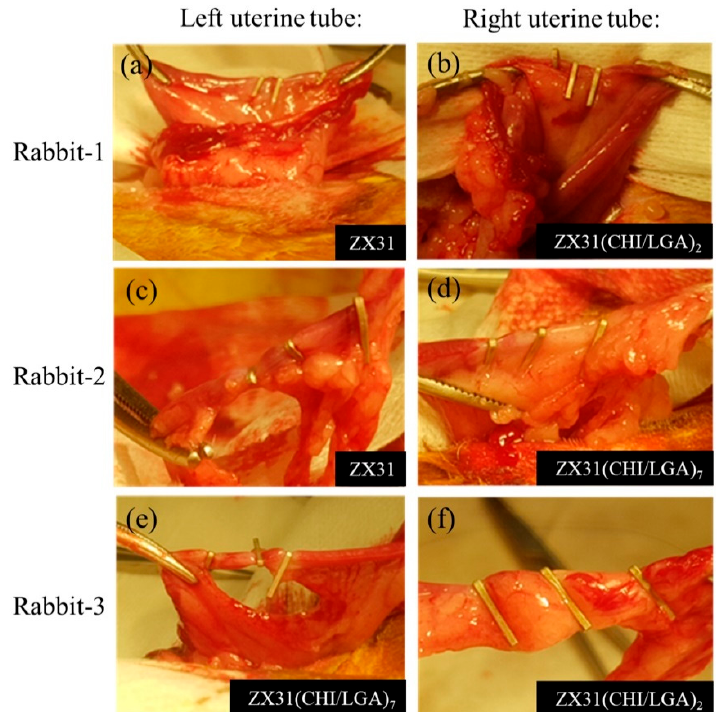
Figure 7. Placement of Mg clips on the uterine tubes of rabbits: ( a , b ) rabbit-1, for which three ZX31 and three ZX31(CHI / LGA) 2 Mg clips were used; ( c , d ) rabbit-2, for which three ZX31 and three ZX31(CHI / LGA) 7 Mg clips were used; ( e , f ) rabbit-3, for which three ZX31(CHI / LGA) 7 and three ZX31(CHI / LGA) 2 Mg clips were used.